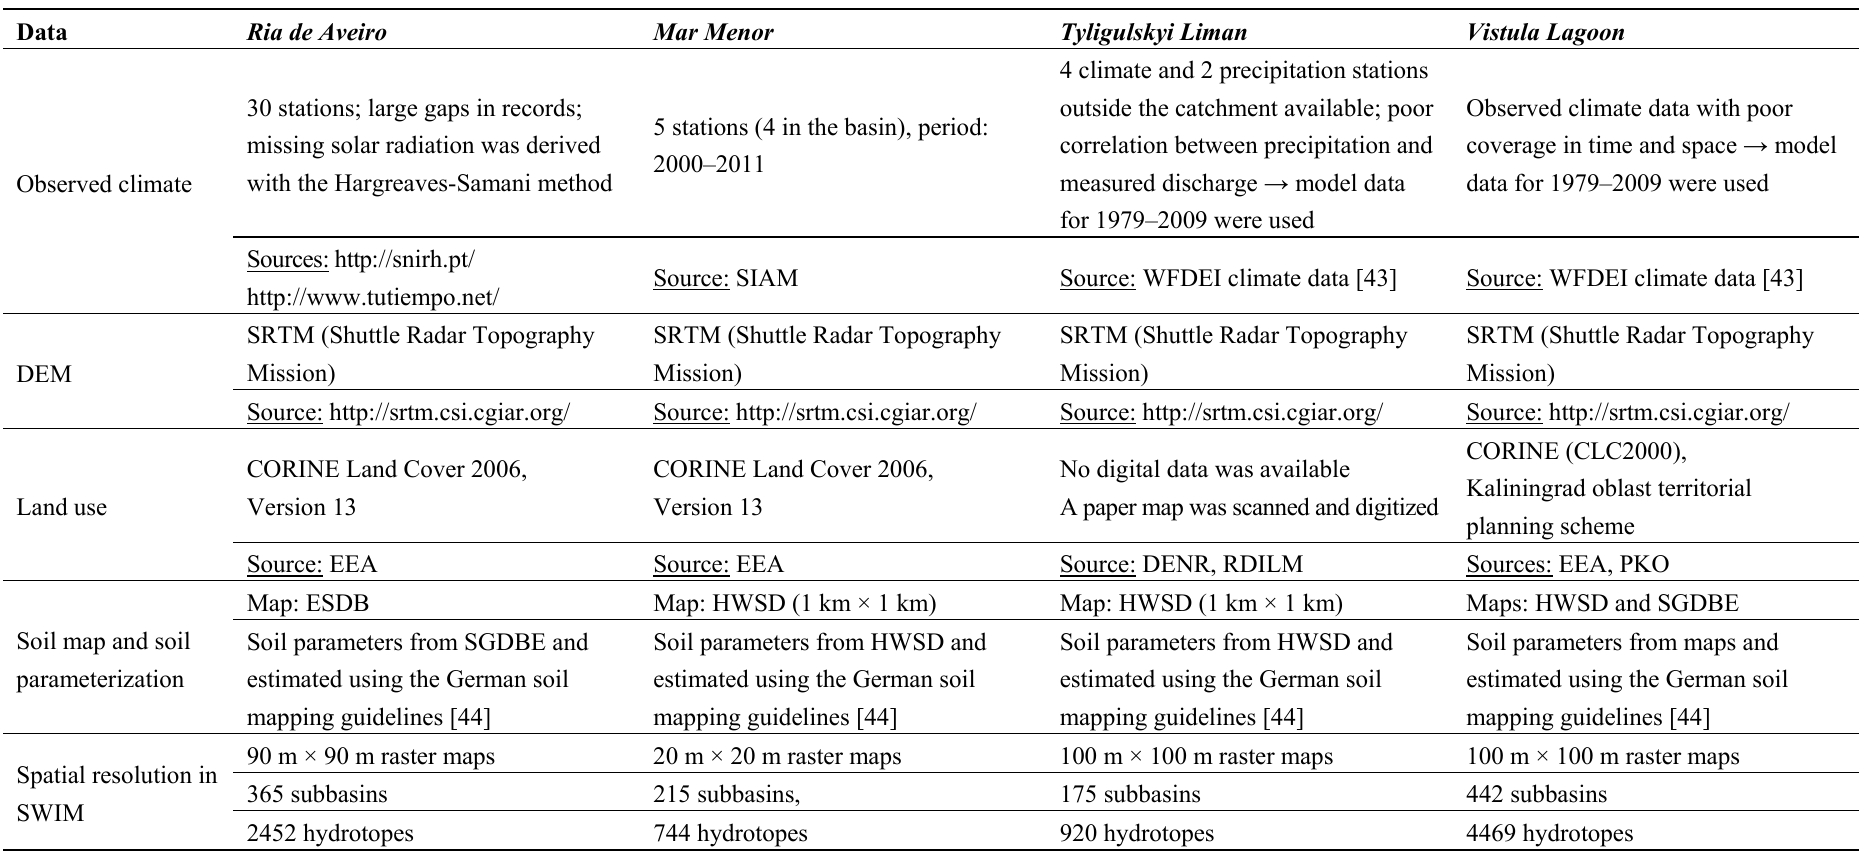
Table 2. Data used for model setup and calibration in the catchments of the lagoons under